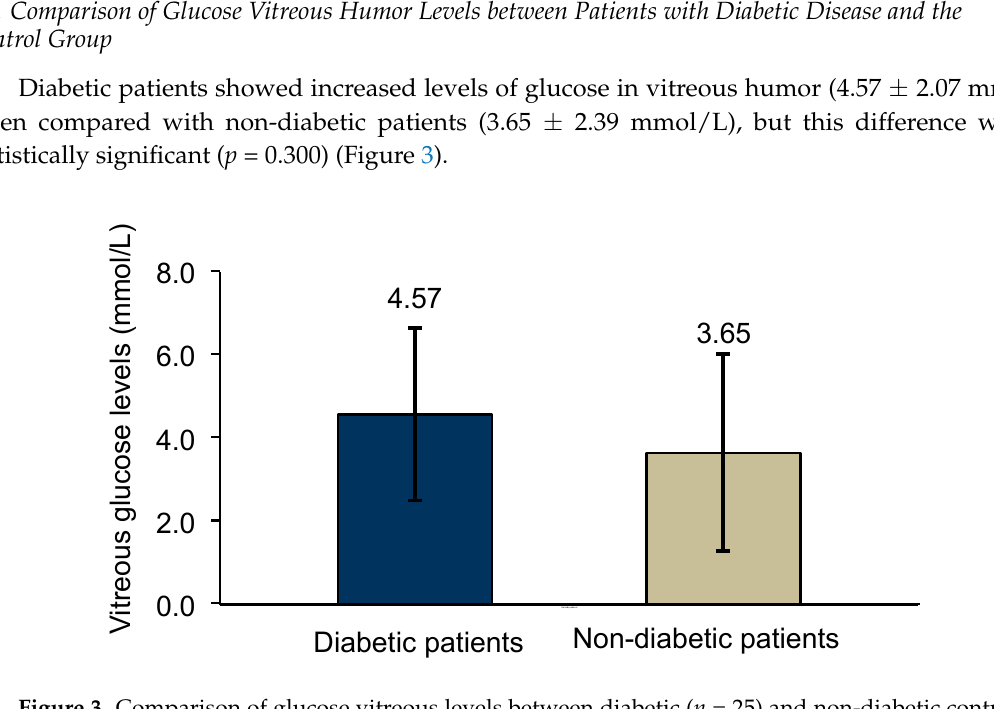
Figure 2. Comparison of VEGF-B levels in vitreous between PDR ( n = 19) and NPDR patients ( n = 6), analyzed with Mann–Whitney test ( p = 0.025).